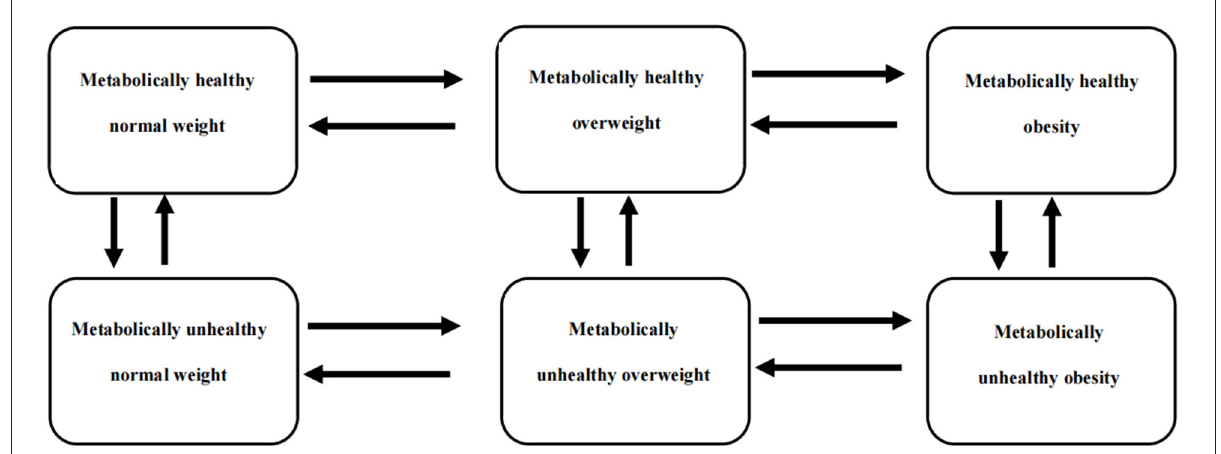
FIGURE1 A six-state Markov model was used to describe the transition patterns among different metabolism-weight phenotypes, which were metabolically healthy normal weight (MHNW), metabolically healthy overweight (MHOW), metabolically healthy obesity (MHO), metabolically unhealthy normal weight (MUNW), metabolically unhealthy overweight (MUOW), and metabolically unhealthy obesity